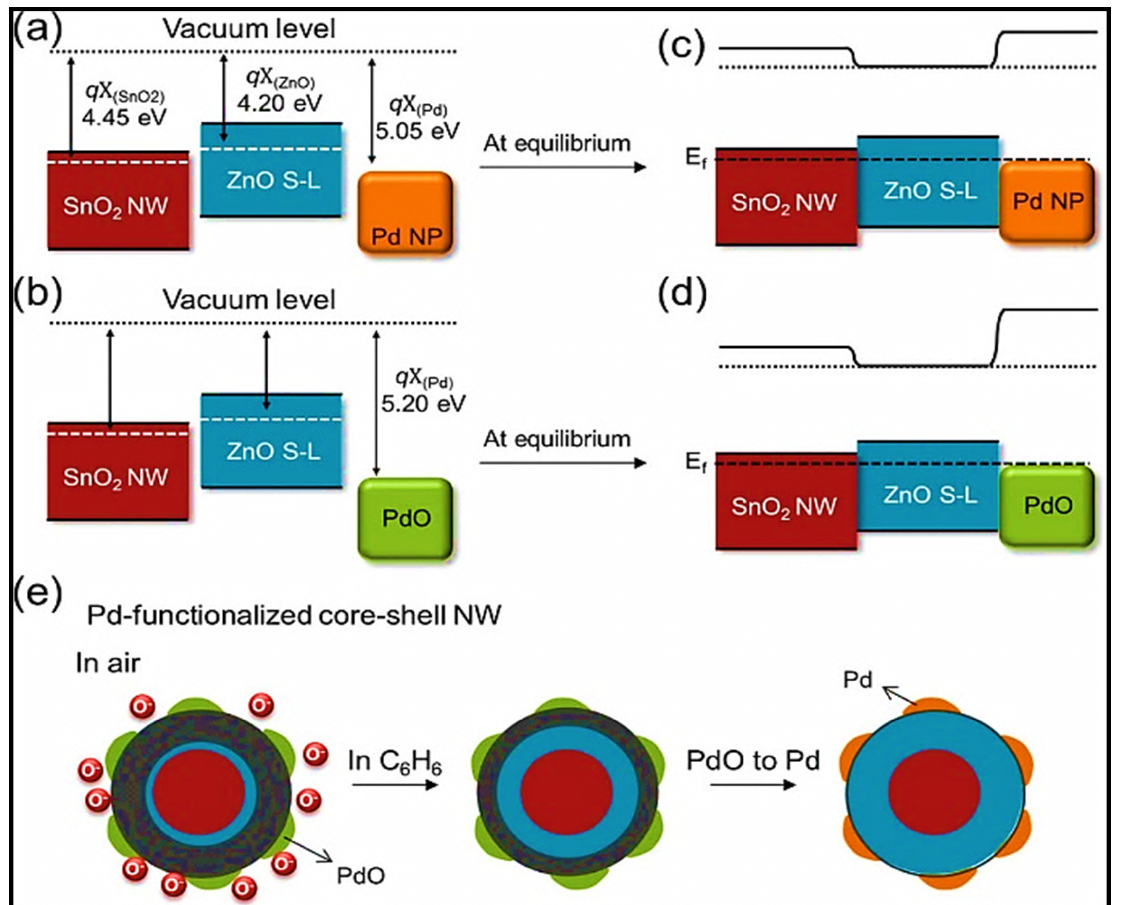
Figure 16. ( a – d ) Schematic of the energy levels of SnO 2 -ZnO-Pd and SnO 2 -ZnO-PdO systems and the development of heterojunction barriers. ( e ) Change in depletion layer width in the presence of Pd. Reproduced from [104] with the permission of Elsevier.